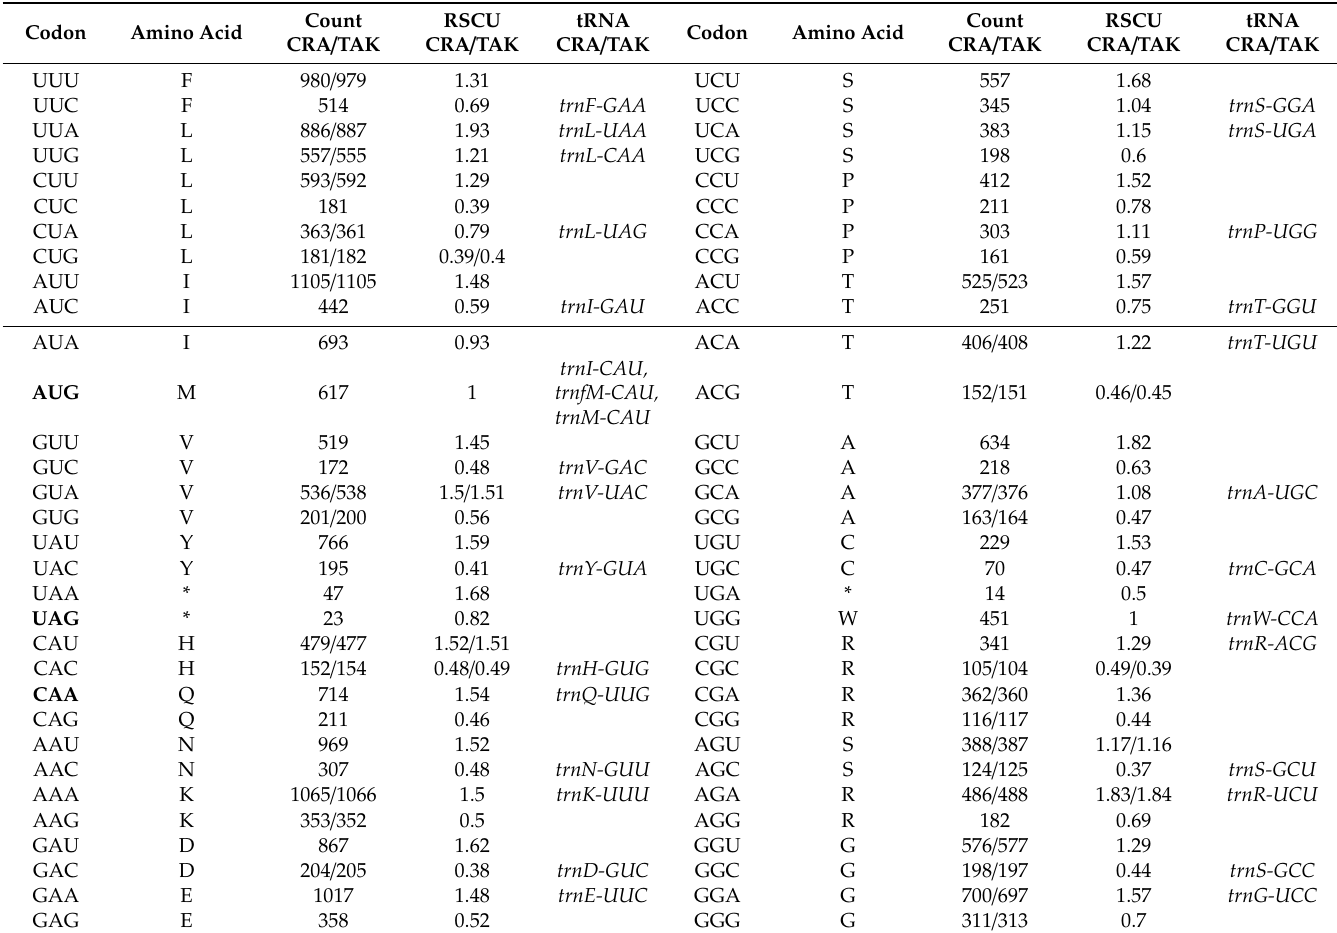
Table 3. Codon usage and codon–anticodon recognition pattern for tRNA in R. crataegifolius and R. takesimensis cp genome. Species abbreviations, CRA and TAK, represent R. crataegifolius and R. takesimensis ,